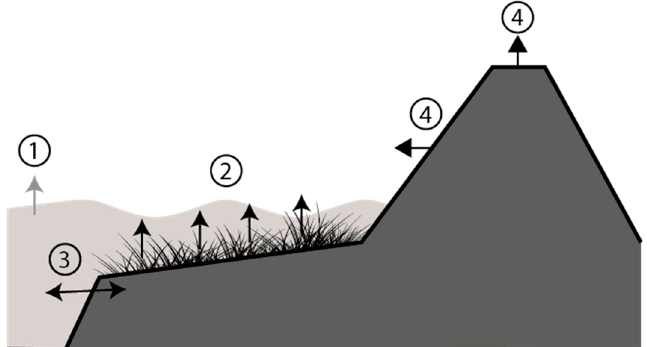
Figure 2. The processes modelled within the framework. (1) Sea-level rise, (2) vertical sediment accretion and compaction, (3) marsh retreat, and (4) dike reinforcement.